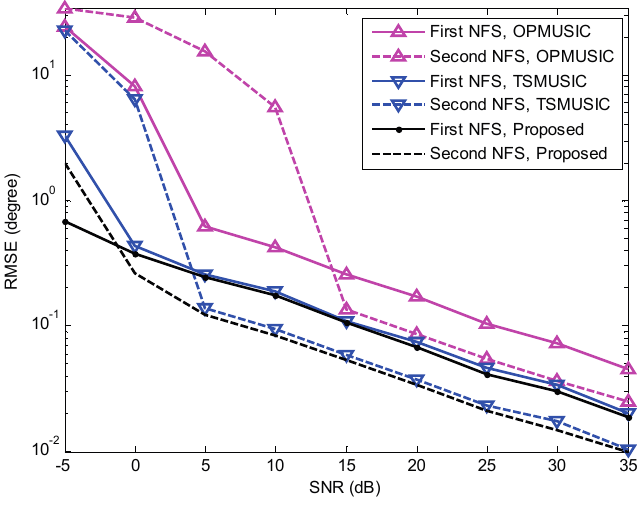
Figure 5. Root mean-square errors (RMSEs) of near-field sources (NFSs) DOA estimates versus SNR. 500 independent trials are realized for each of the three